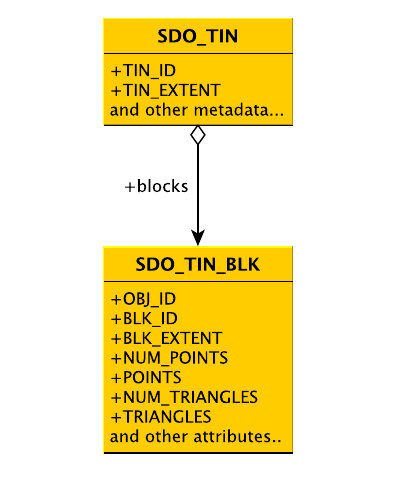
Figure 13: TIN in Oracle